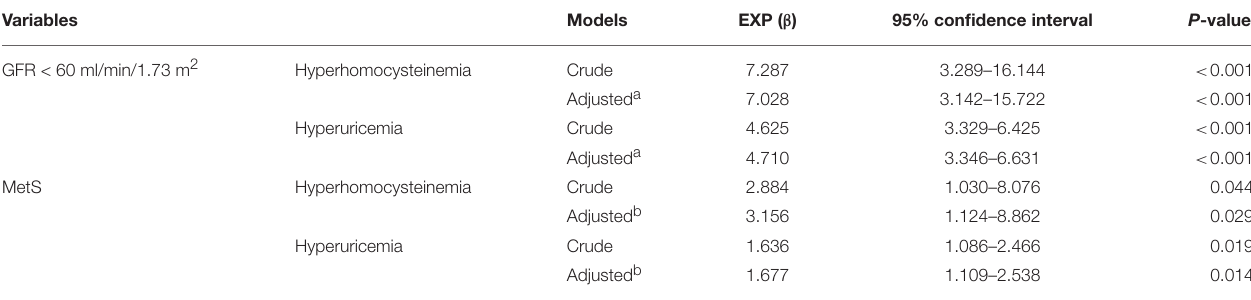
TABLE 2 | Associations of hyperhomocysteinemia and hyperuricemia with GFR < 60 ml/min/1.73 m 2 and MetS in Chinese centenarians. Variables